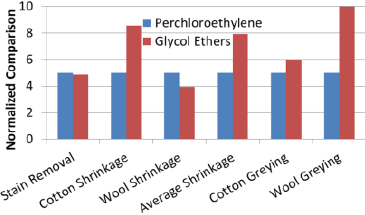
Figure 4. Comparison of cleaning efficacy of GEs with PCE as a